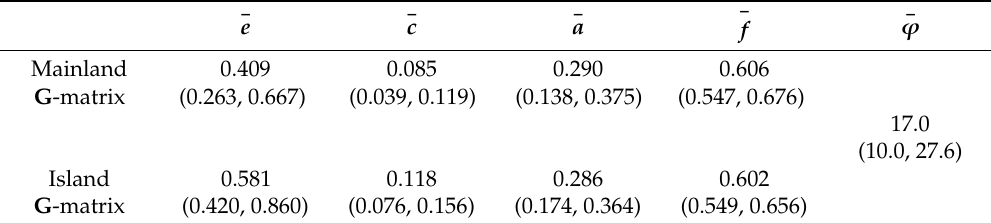
Table 5. Comparison of the additive genetic ( G ) variance-covariance matrices, estimated within the Mainland and Island population groups of E. globulus , based on measures reflecting the influence of G -eigenstructure on response to selection (with 95% confidence intervals within